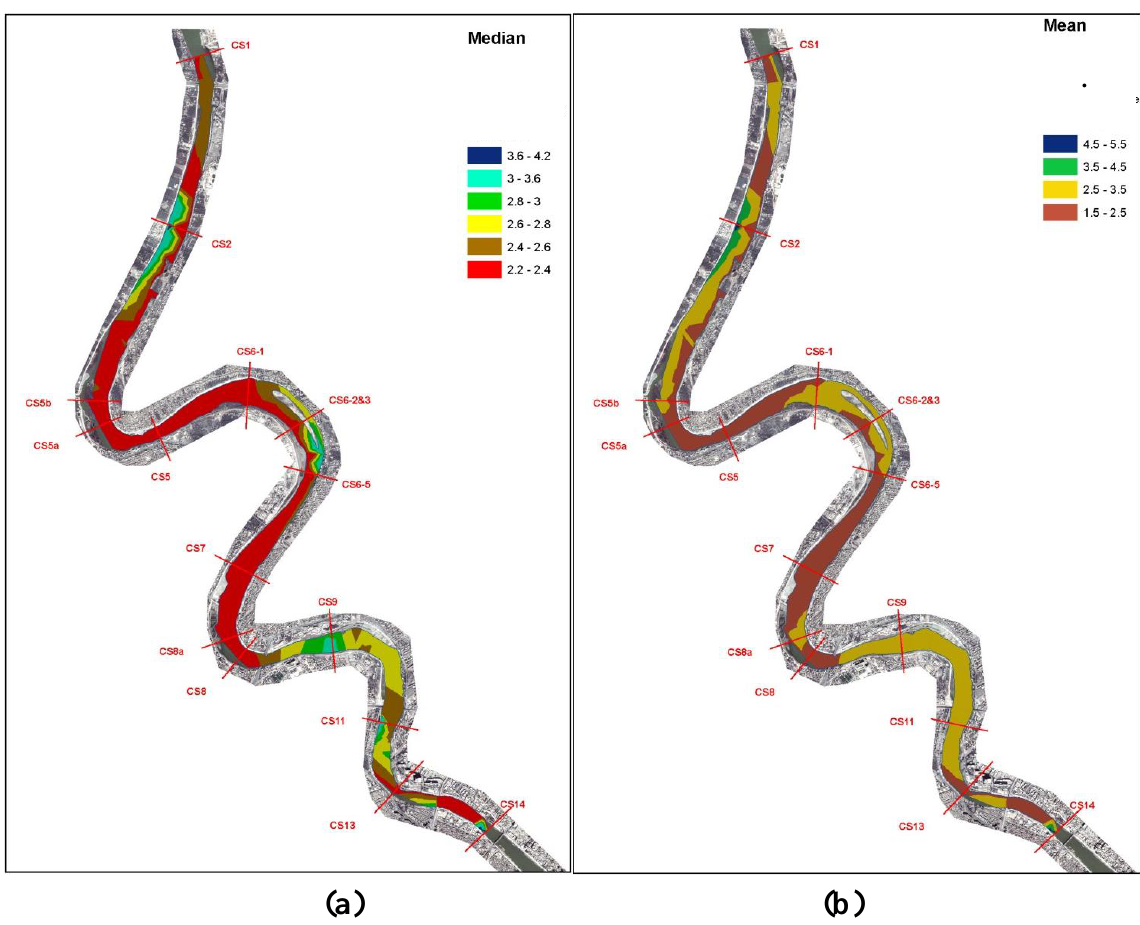
Figure 12. Distribution of the sediment (a) median grain size; (b) mean grain size of the bed of the Tigris River in Baghdad. the meander disturbed the characteristics of the